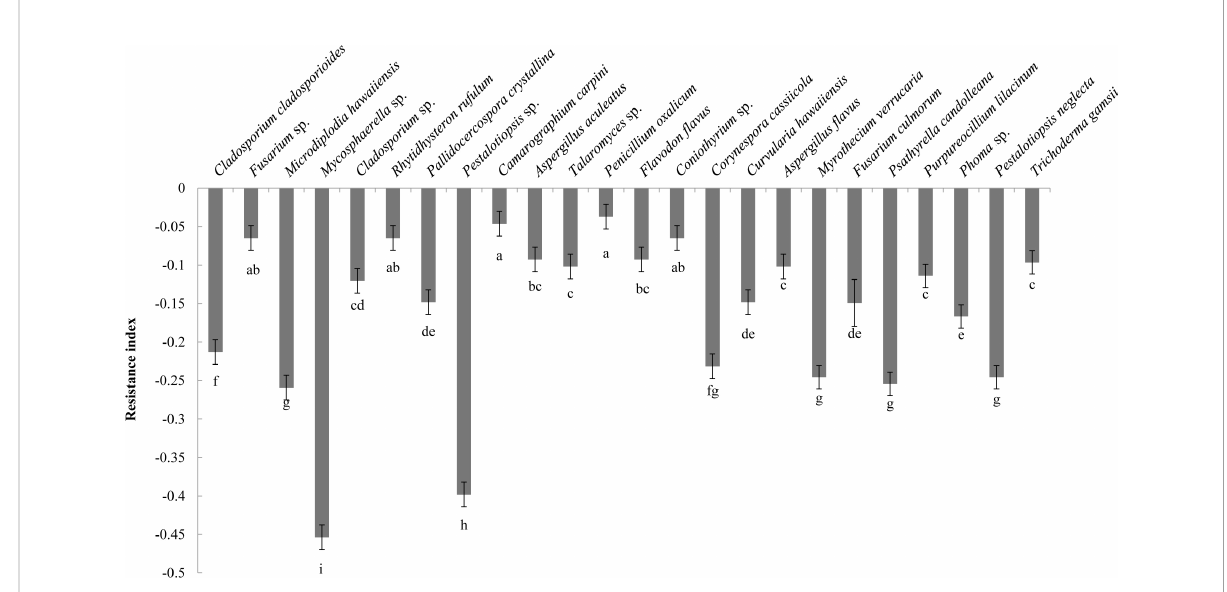
FIGURE 2 The allelopathy index (resistance index) of the fungal strains. Values marked with different letters are signi fi cantly different at